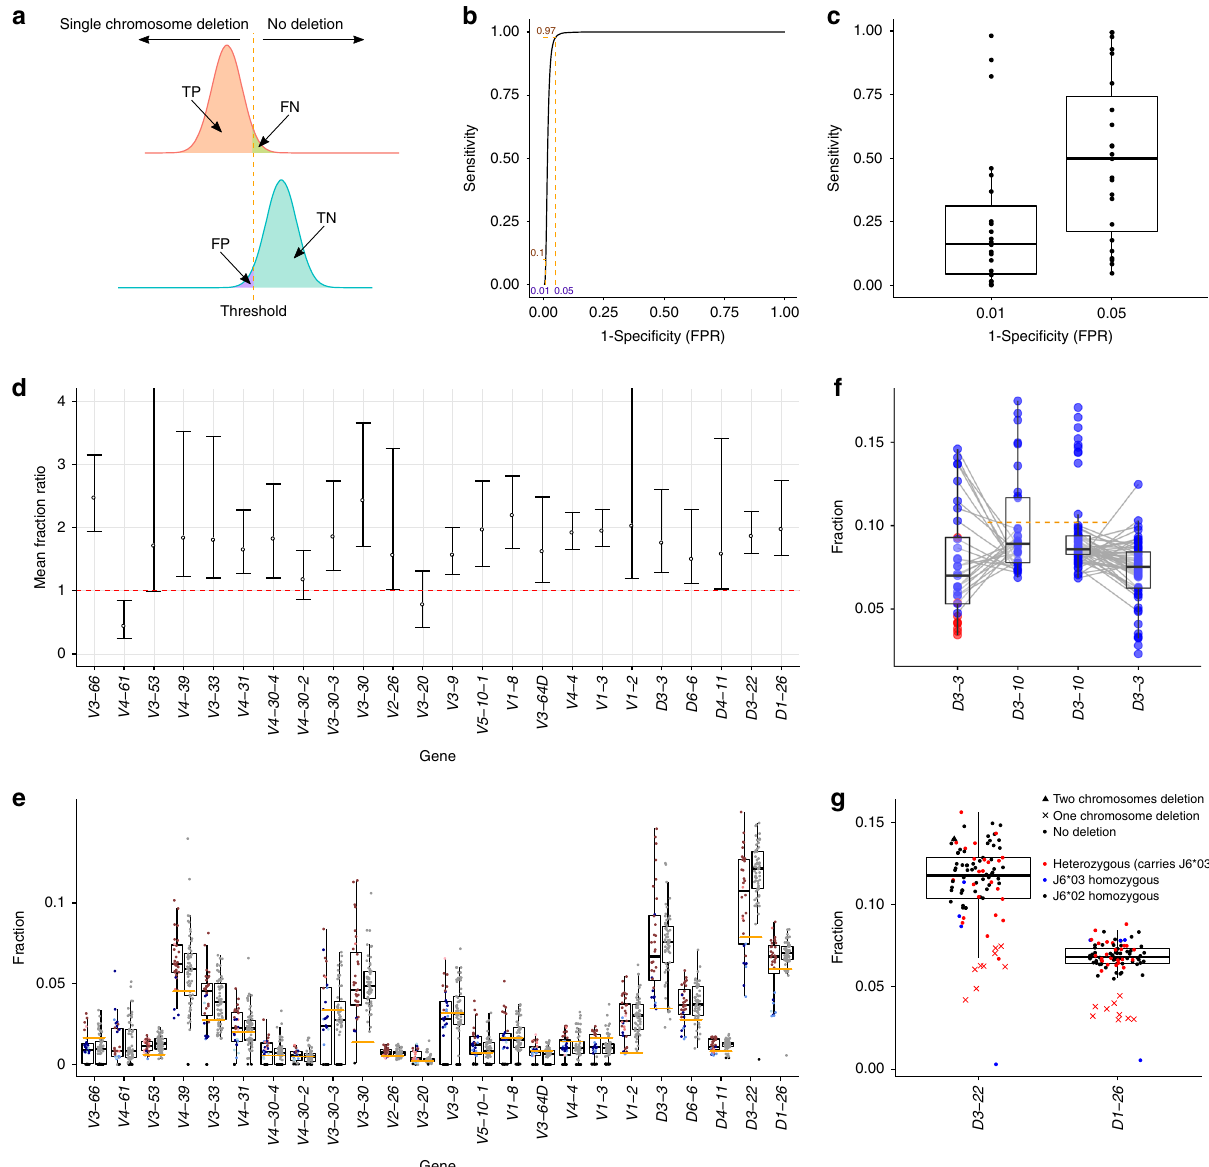
Fig. 6 Inferring single gene deletions by their relative usage. a An example calculation of true positive (TP), true negative (TN), false positive (FP), and false negative (FN) for two t distributions that estimate the gene usage of individuals with zero or one chromosome gene deletion for V3-66 . b An example ROC curve for V3-66 . c Box plots of sensitivity distributions for FPR of α = 0.01 (left) and α = 0.05 (right). d Point estimator and 95% con fi dence interval for the ratio between the mean gene usage of individuals with no gene deletion and individuals with a single chromosome gene deletion. Genes shown have at least two individuals for each group with a certainty level of lK > = 10. e Box plots of V and D gene usage for the genes appearing in d . Each gene distribution appears once for the J6 heterozygous individuals (left) and once for the J6 homozygous individuals (right). Each dot represents an individual. For the J6 heterozygous individuals, color corresponds to gene deletion from both chromosomes (black), single chromosome (blue), or no deletion (red). Shades correspond to the certainty level of deletion inference. The orange cutoffs separate individuals with a single chromosome deletion from individuals with no deletions in that gene, with FPR of 0.05. f Box plots of D3-3 and D3-10 usage for J6 heterozygous samples (left) and J6 homozygous samples (right). Gray lines connect between D3-3 and D3-10 relative usage of the same individual. Orange cutoffs separate individuals with high and low D3-10 usage that correspond to single chromosome deletions in D3-3 . Blue points represent individuals with no D3-3 deletion, and red points represent individuals with a single chromosome deletion. g Box plots of the usage of D3-22 and D1-26 for all individuals. Blue and black points represent homozygous individual in J6*03 and J6*02 alleles, respectively, red points represent heterozygous individuals carrying J6*03 allele. The shape of the point represents